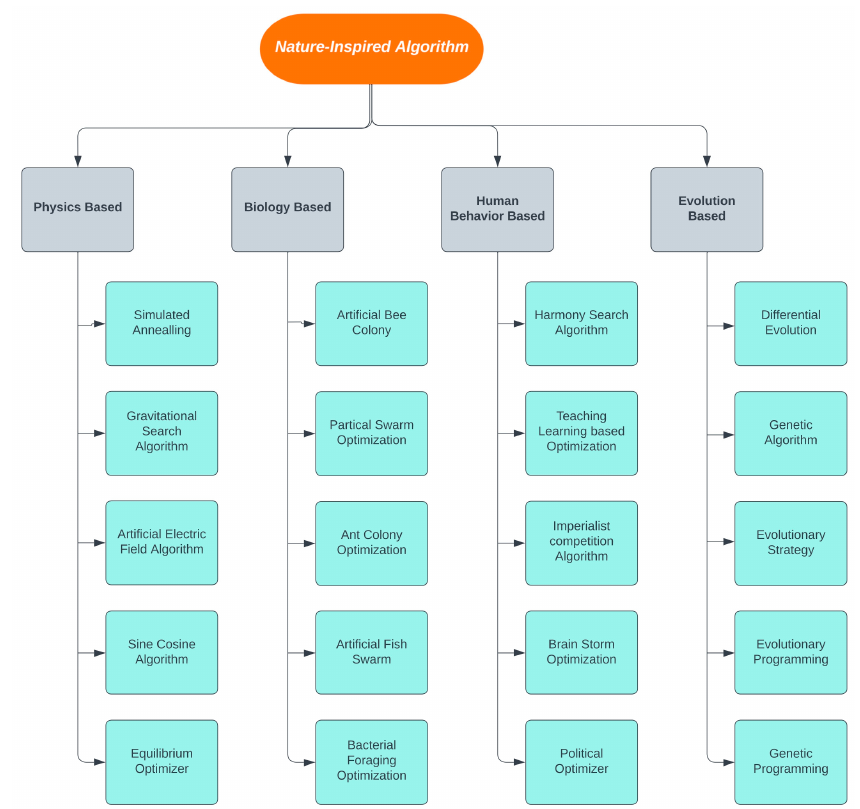
Figure 1. The hierarchical distribution of nature-inspired algorithms.